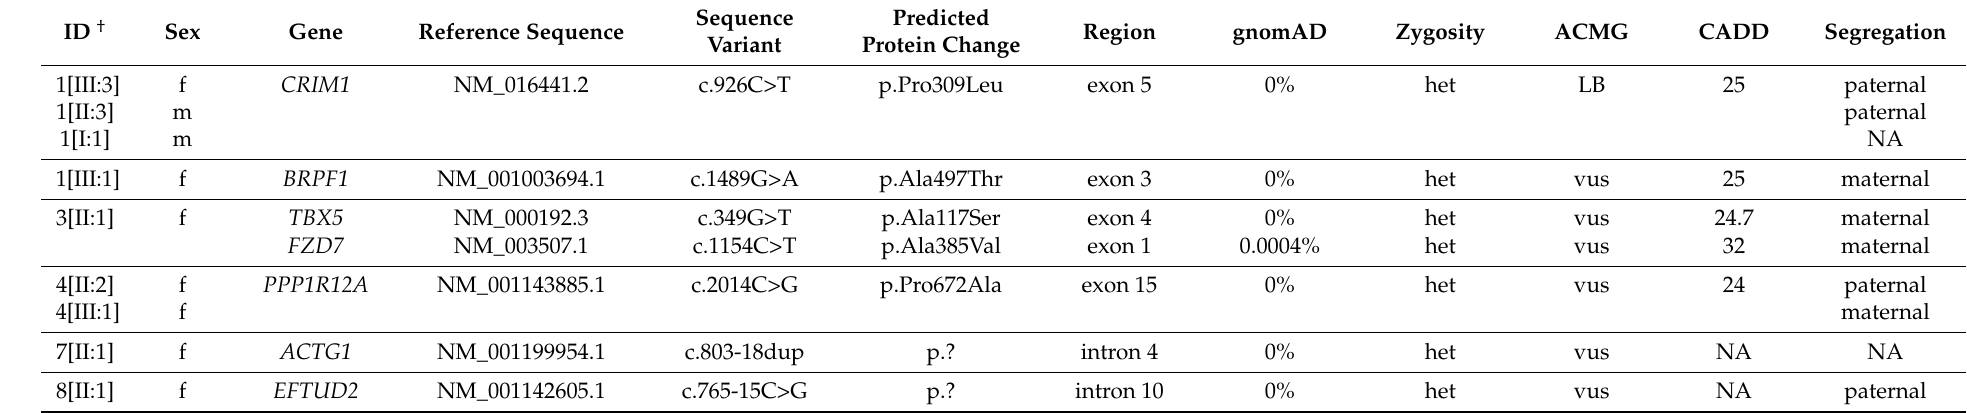
Table 3. Additional variants identified by